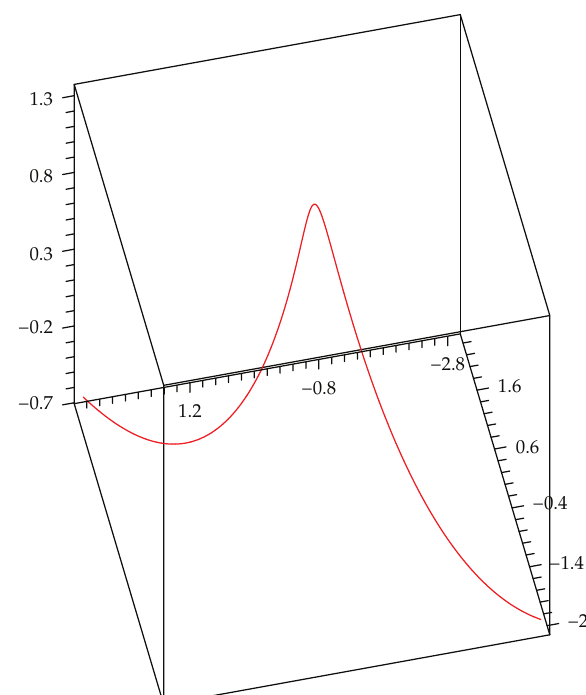
Figure 6: Singular locus of focal